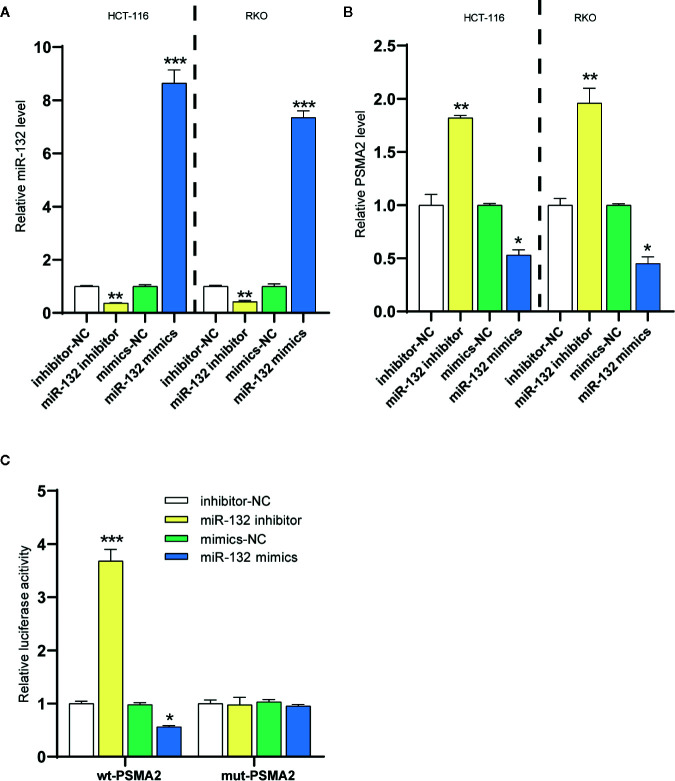
PSMA2 was a target of miR-132. (A) The transfection efficiency of miR-132 overexpression or knockdown was determined in CRC using RT-PCR. (B) The expression level of PSMA2 was determined after miR-132 overexpression or knockdown. (C) Dual luciferase assay was applied to determine the interaction among miR-132 and PSMA2. *P < 0.05, **P < 0.01, ***P < 0.001.